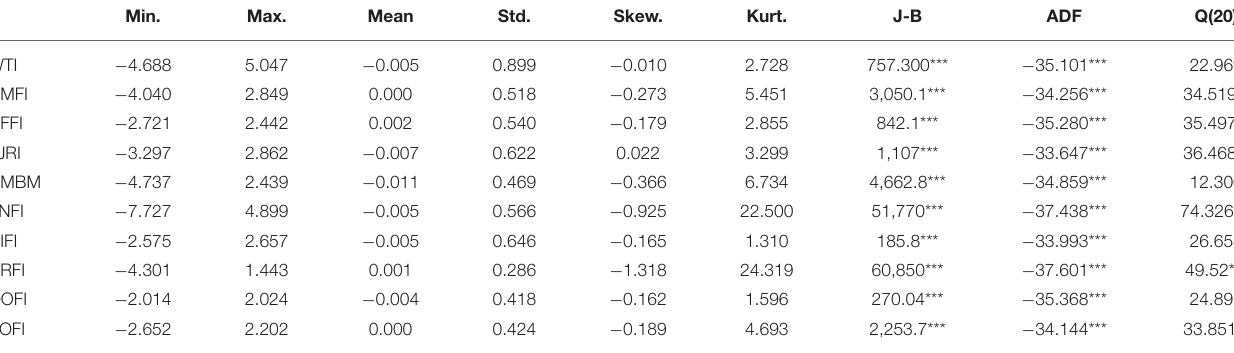
TABLE 2 | Descriptive statistics of variables.